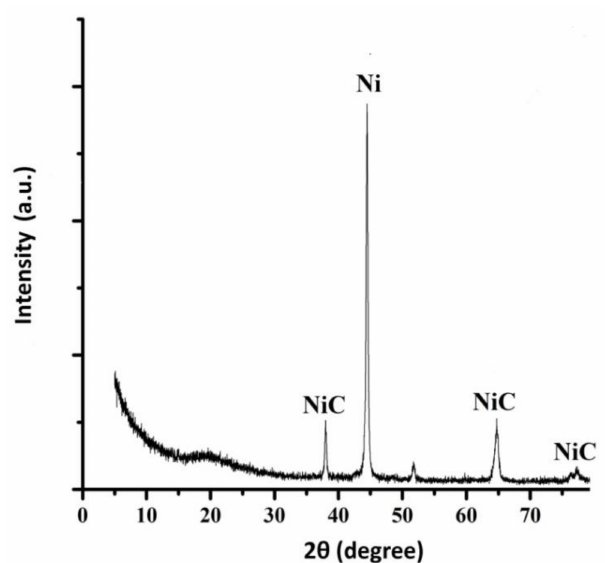
Figure 3. X-ray diffraction pattern of the nickel–GO CEC obtained at the time ratio of the cathodic and anodic periods t c /t a = 10:1.